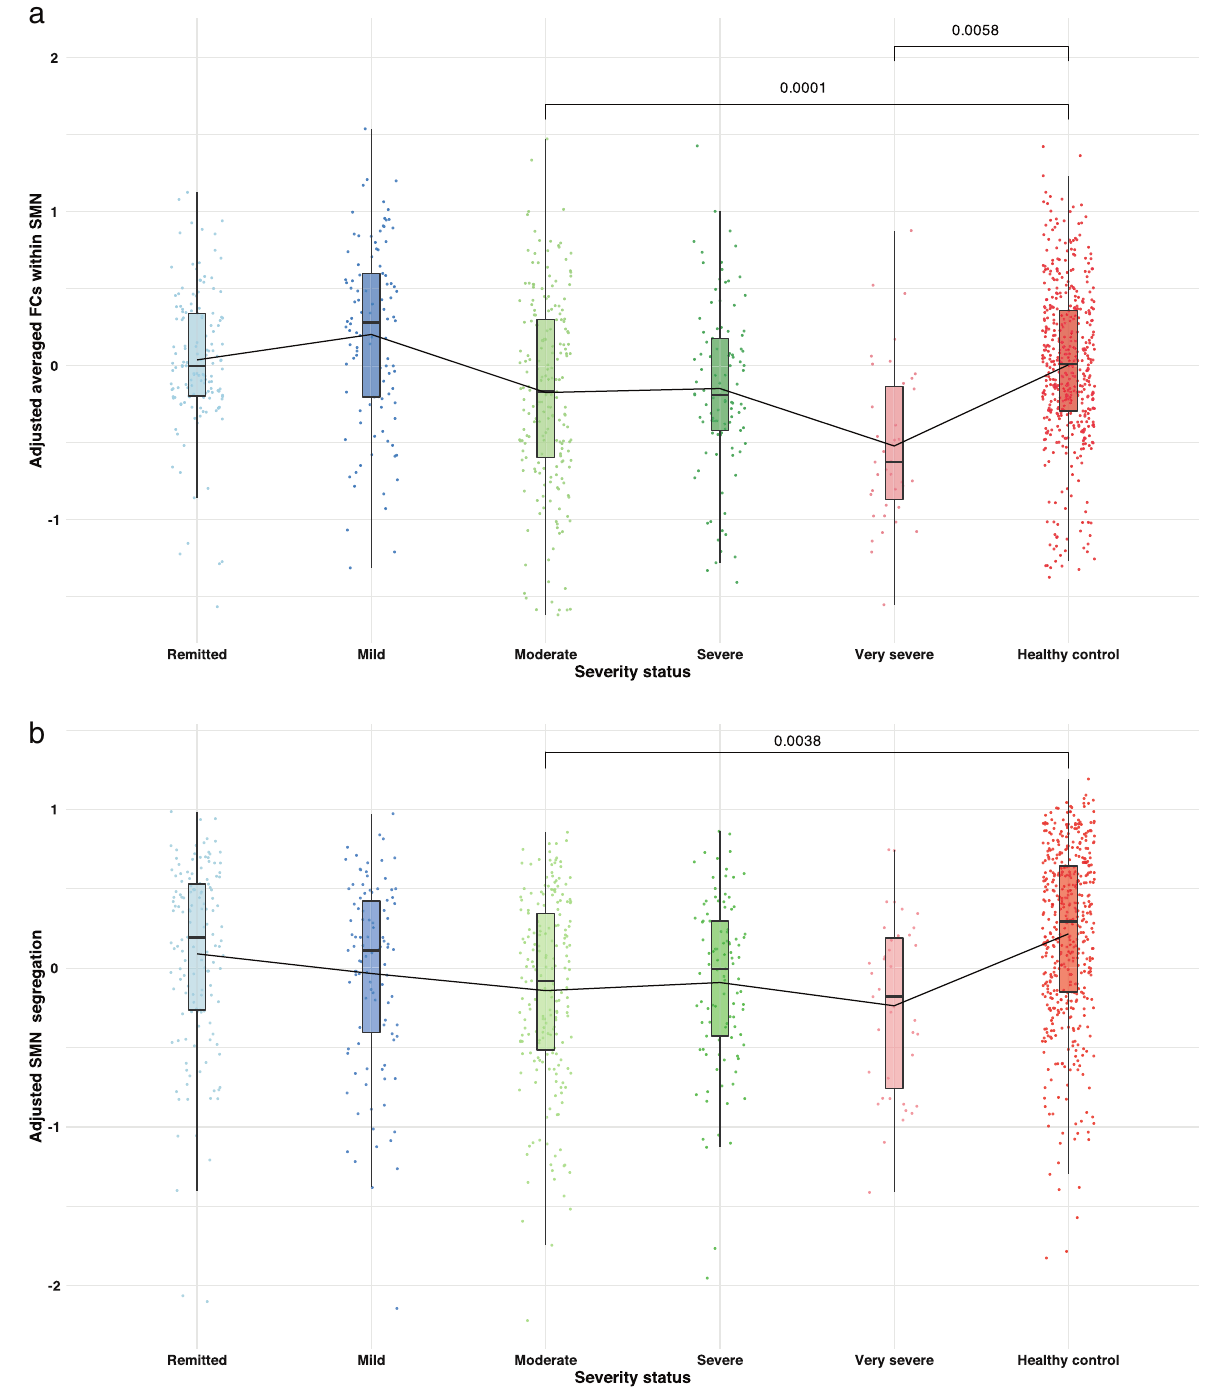
Fig. 2 Bar-plots of the averaged FCs for different level of depression severity within SMN and of SMN segregation. The means reported in these bar-plots are adjusted for age, gender, mean framewise displacement and site according to the linear mixed model and the reported p - values are signi fi cant after Bonferroni correction for multiple comparisons ( p < 0.05). a The averaged FCs within somatosensory network (SMN) for patients ’ groups de fi ned according to depression severity and healthy participants. b The averaged SMN segregation for patients ’ groups de fi ned according to depression severity and healthy